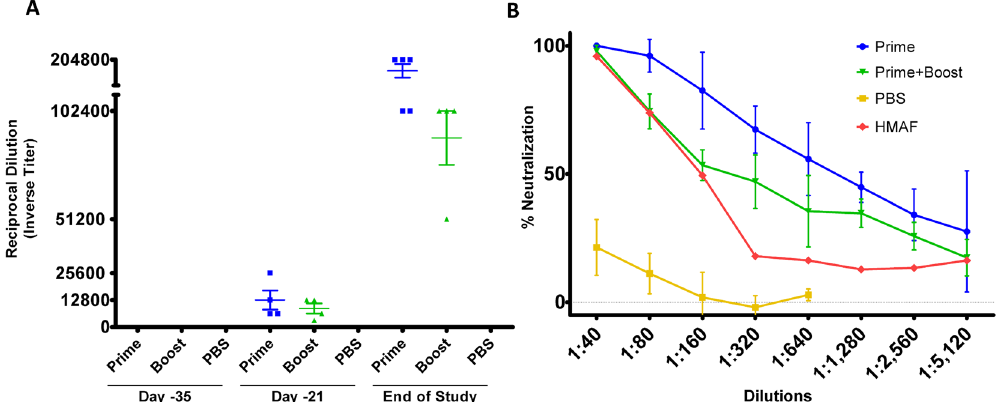
Figure 5. In vivo experiment humoral immune responses. Study endpoint mouse sera collected from in vivo experiment outlined in Fig. 3 along with pilot study mice from similar doses from pre-challenged status (for days − 35 and − 21). Mice sera were run in duplicate with each group indicating four separate animal sera tested for humoral responses. ( A ) Enzyme linked immunosorbent assay (ELISA) titers using plates coated with 1ug of purified Δ GrVSV-CCHFV-GPC Δ antigens and diluted various animal sera. ( B ) Plaque reduction neutralization test (PRNT) from diluted endpoint mouse sera with CCHFV (Strain: Turkey2004) incubated on SW-13-CDC cells. Hyperimmune mouse ascitic fluid (HMAF) was used as a positive control, kindly provided by T. Ksiazek.